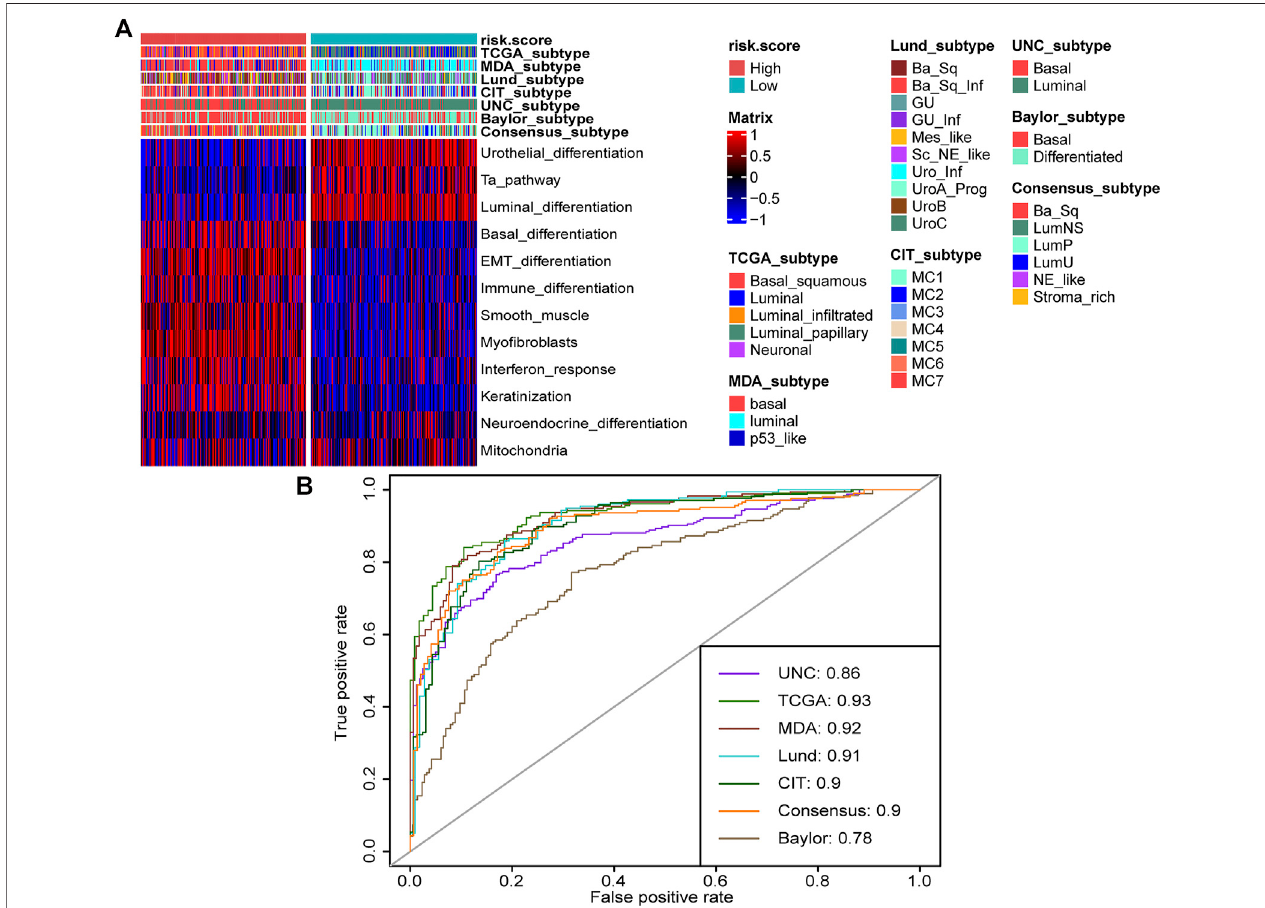
FIGURE5| TNFfamily – basedriskscore strati fi edmolecularsubtypes ofBLCAin TCGA cohort. (A) The heatmap ofdifferentTNF-based riskscoregroups, seven molecular subtype classi fi cations, and bladder cancer – associated signatures in BLCA. Activated or inhibited pathways are marked asred or blue, respectively. (B) AUC plot of the risk score for predicting seven molecular subtype classi fi cations in BLCA.